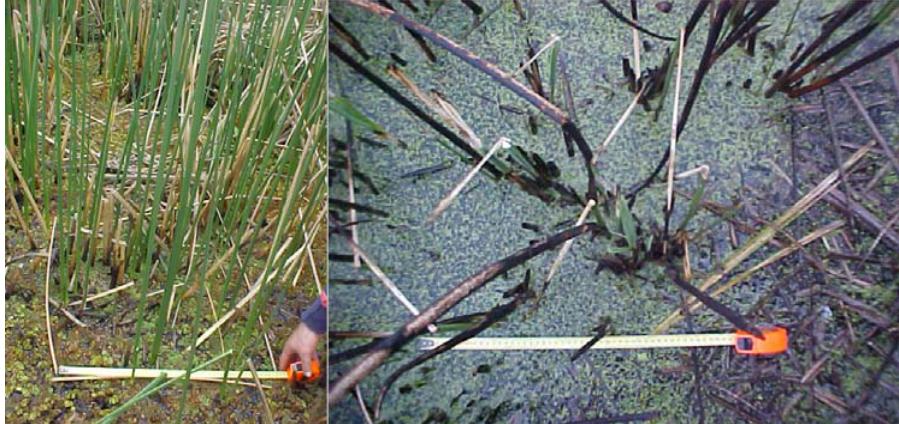
Figure 3. Photographs of one of the test sites, prior to the burning events (2008.02.04, left) and after them (2008.09.01, right). A strong decrease in the emerged biomass was observed. Also, it can be seen that the soil condition is similar in both dates.